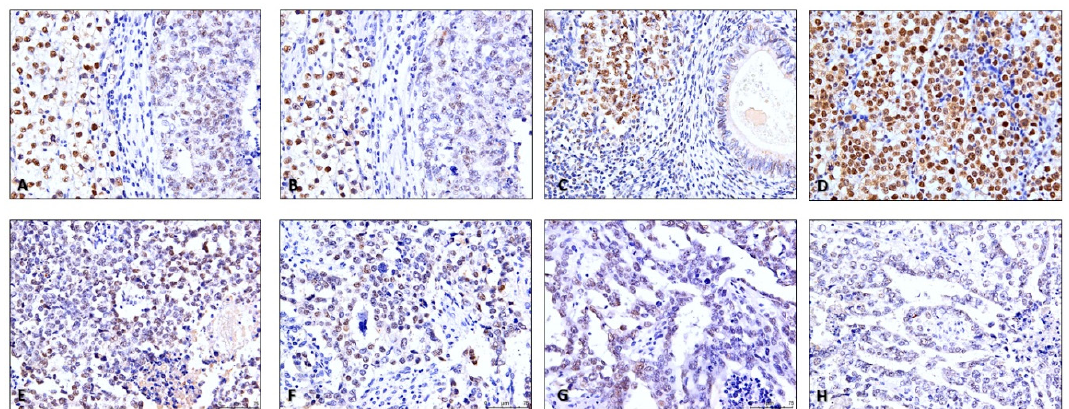
Figure 7. Illustrative examples of mismatch repair proteins staining in testicular germ cell tumors. ( A ) and ( B )—MLH1 ( A ) and PMS2 ( B ) staining patterns in a mixed tumor composed of seminoma (on the left) and embryonal carcinoma (on the right). Notice the clearly weaker intensity staining in